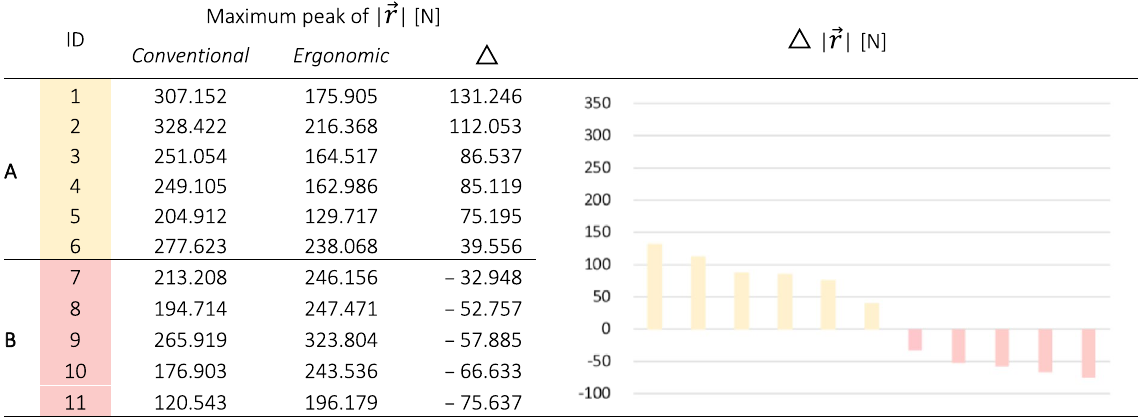
−→ r | ) for each study participant and the